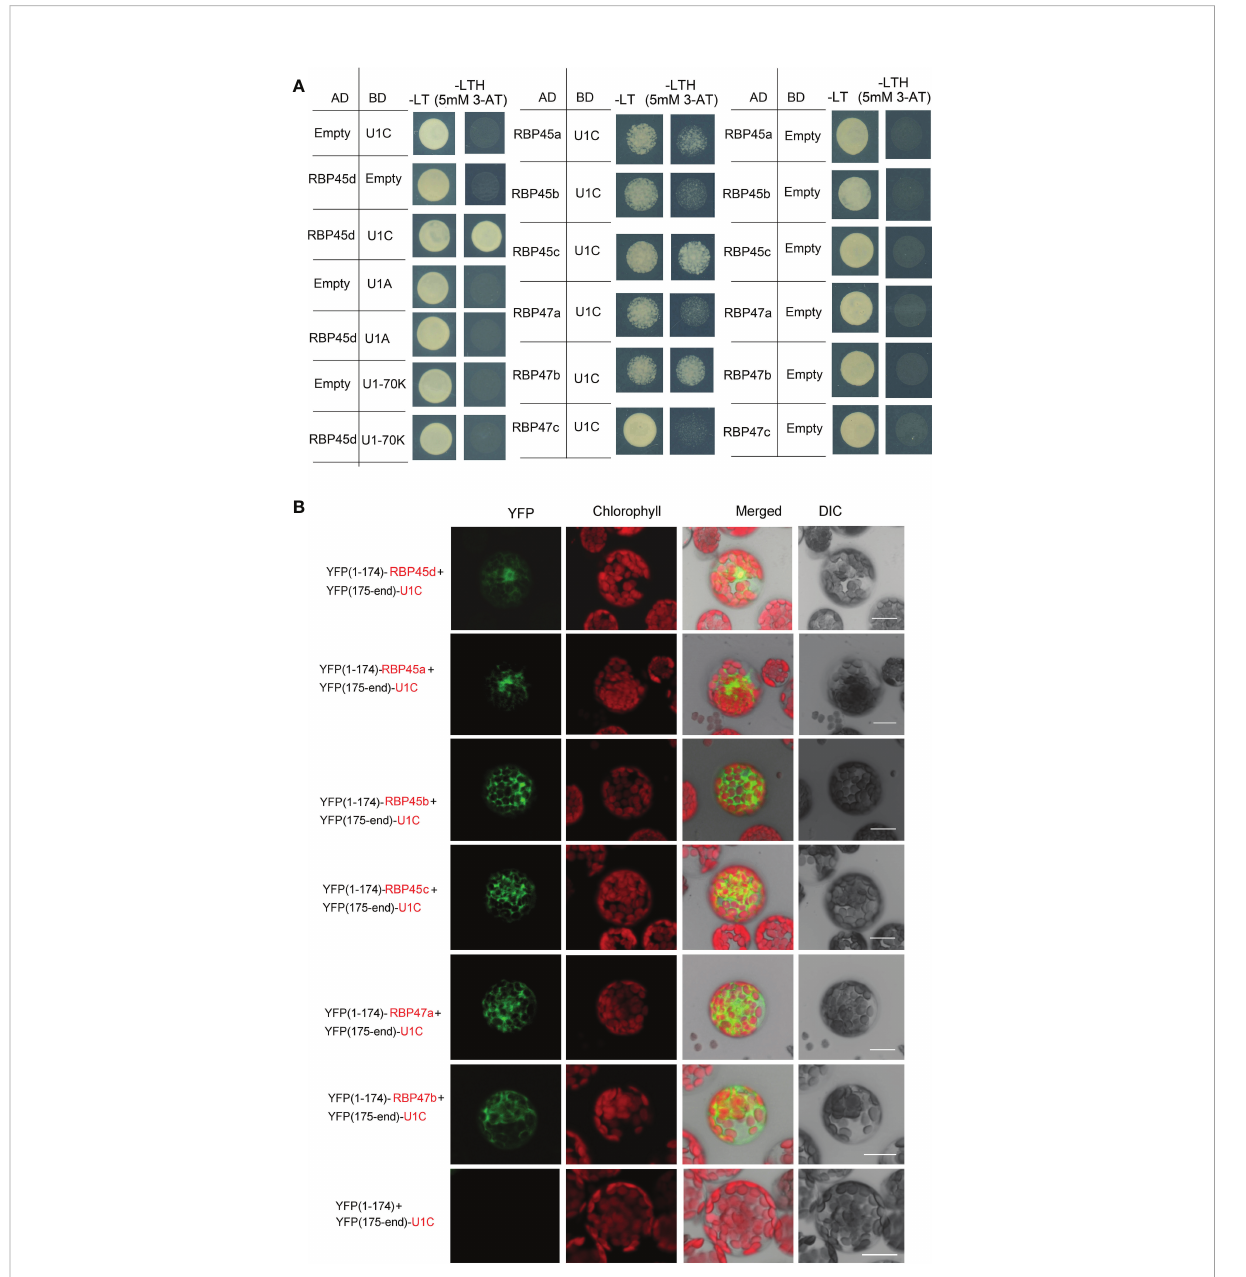
FIGURE 5 RBP45d and other RBP45/47 members interact with U1C. (A) Yeast two-hybrid assays show the interaction between RBP45d and U1C, U1A or U1 70K and the interaction between U1C and RBP45a, RBP45b, RBP45c, RBP47a, RBP47b or RBP47c. The transformed yeast cells were grown on -LT (SD-Leu/-Trp) mediums and -LTH+3-AT (SD- Leu/-Trp/-His with 5 mM 3-AT) mediums. (B) BiFC assay of the interaction between U1C and RBP45d, RBP45a, RBP45b, RBP45c, RBP47a or RBP47b. YFP, fl uorescence of yellow fl uorescent protein; DIC, Differential interference contrast microscopy; Merge, merge of YFP, DIC and chlorophyll. Bar = 15 m